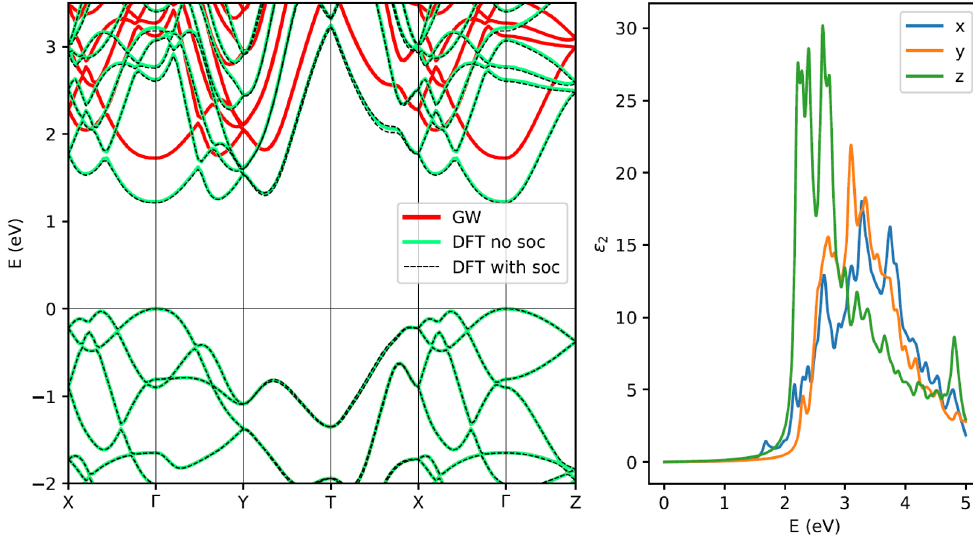
Figure 4. Left panel : Bulk GeS DFT bandstructure neglecting relativistic effects (green, solid) and taking them into account (black, dashed) and its quasiparticle bandstructure (red, solid). Right panel : Imaginary part of the dielectric functions calculated at the GW+BSE method, with light polarized along X, Y, and Z